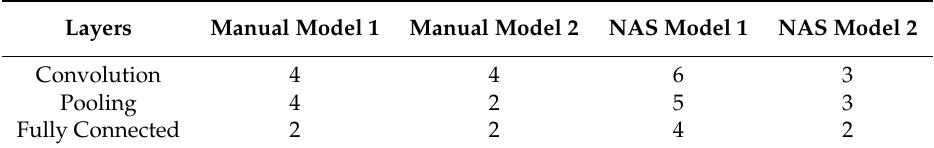
Table 4. The architectures used for the